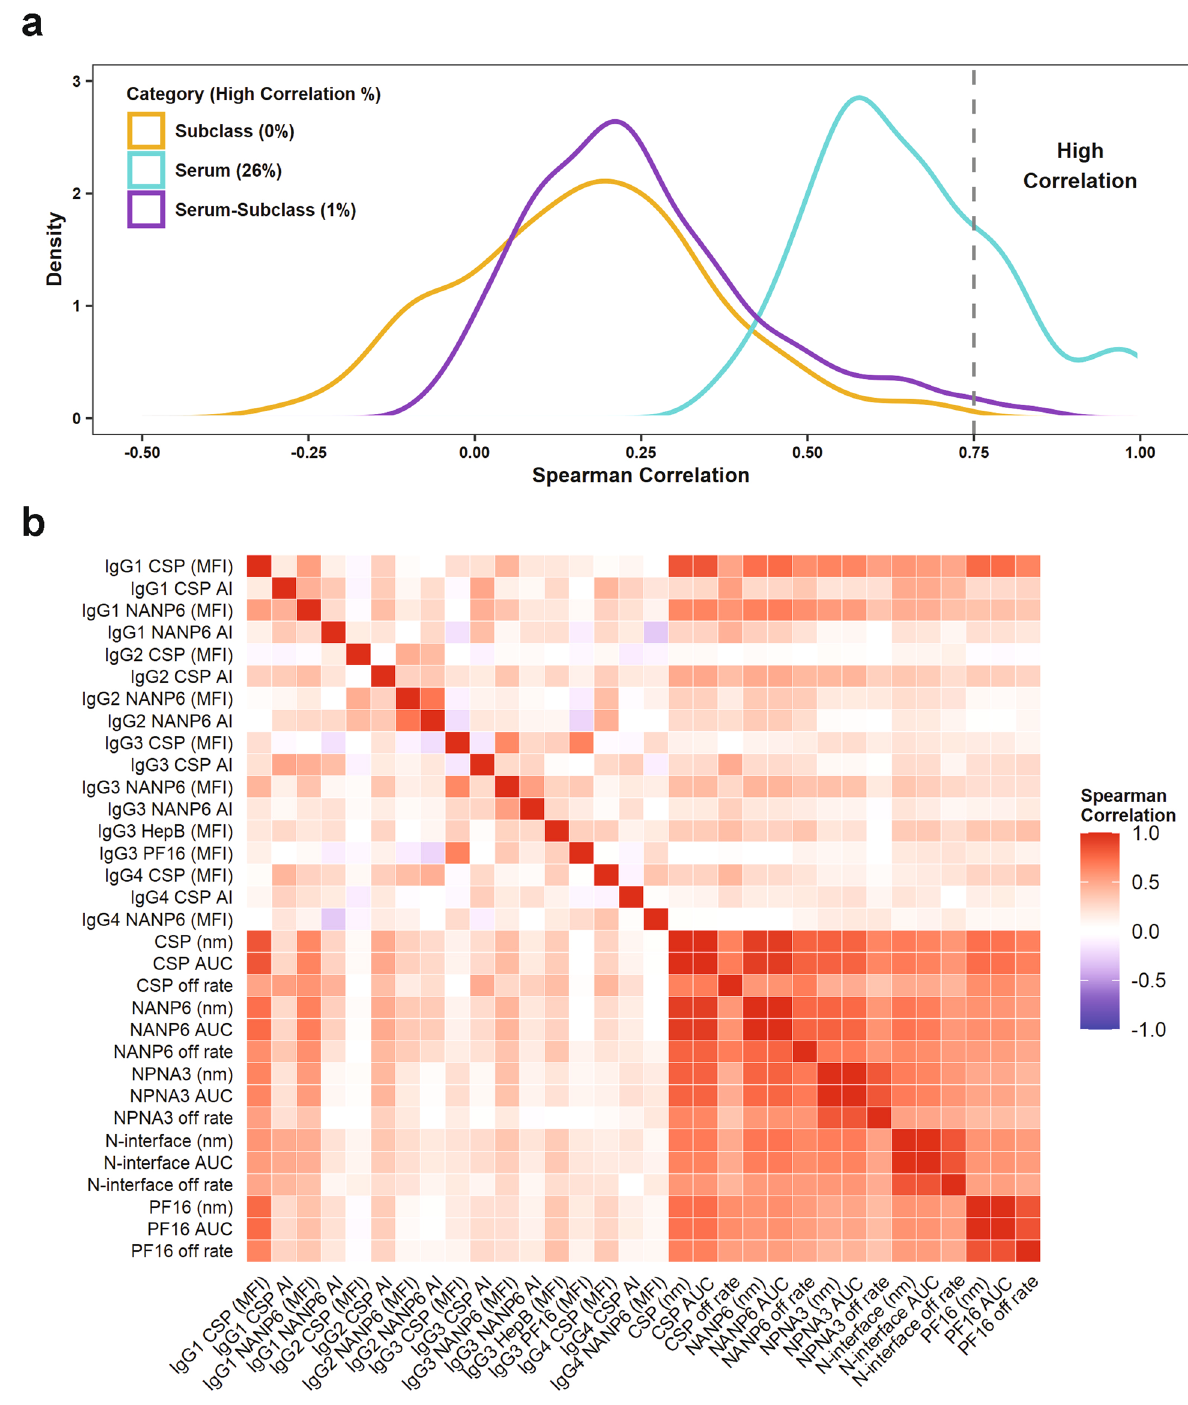
Fig. 1 Distinct vaccine elicited antibody responses. The distribution of Spearman ’ s rank correlation coef fi cients is shown between measurements within and between assay types, with the percent of correlation coef fi cients above 0.75 indicated ( a ). A heatmap of all correlation values, is also shown. This heatmap is symmetric about the diagonal, with inter-assay subclass-serum correlations shown in the upper right and lower left quadrants, intra-assay subclass correlations shown in the upper left quadrant, and intra-assay serum correlations shown in the lower right quadrant ( b